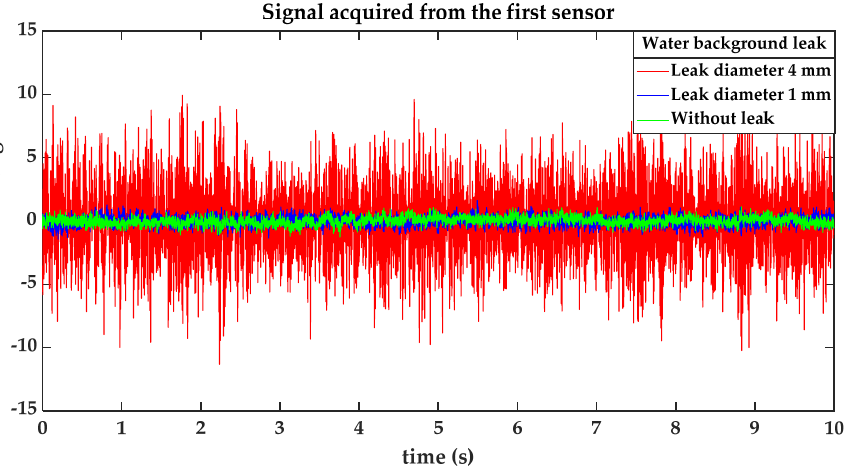
Figure 8. Signals were acquired from the first sensor with a background leak of 1 mm and 4 mm in diameter.